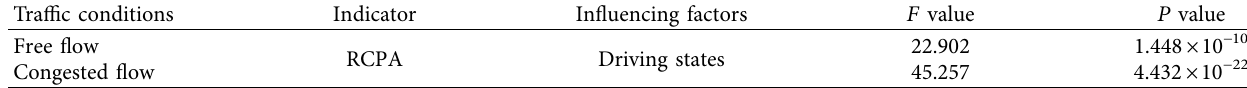
Table 10: One-way ANOVA of the infuence of driving state on RCPA.